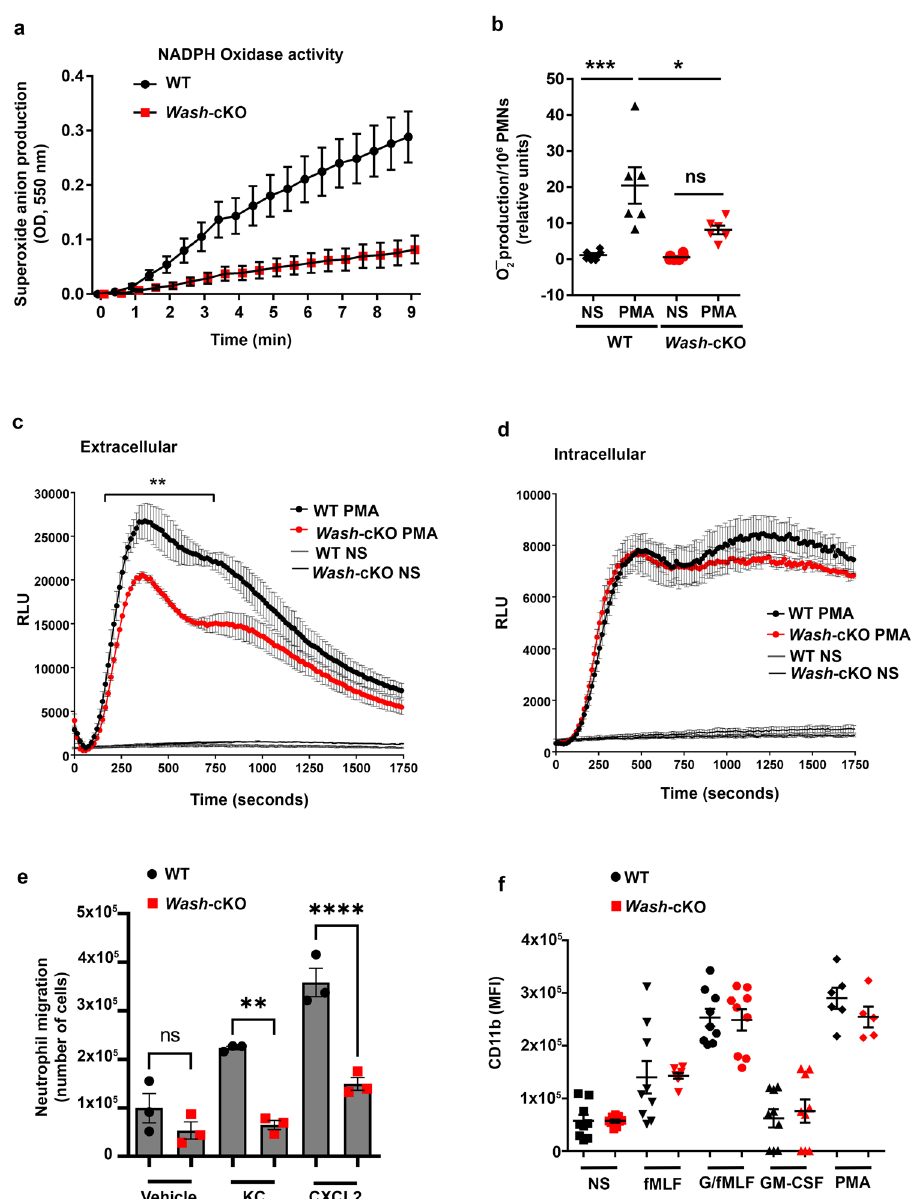
Fig. 6 | Wash -de fi ciency is associated with impaired ROS production and migration.a Representativekineticanalysisoftheproductionofsuperoxideanion by WT and Wash -cKO (Washc1 Δ haemo ) neutrophils stimulated with PMA and mea- sured by the cytochrome c reduction assay. Mean ± SEM, n =3. b Quantitative analysis of superoxide anion production. Each symbol represents an individual mouse from 2 independent experiments. n =6. Mean ± SEM. * p =0.0166; *** p =0.0002. One-way ANOVA, Tukey ’ s multiple comparisons. c Study of the production of extracellular reactive oxygen species by WT and Wash -cKO neu- trophils as analyzed by chemiluminescence using the cell impermeant probe iso- luminol.Mean±SEM, n =3.** p =0.0193(areaunderthecurve),two-tailedunpaired